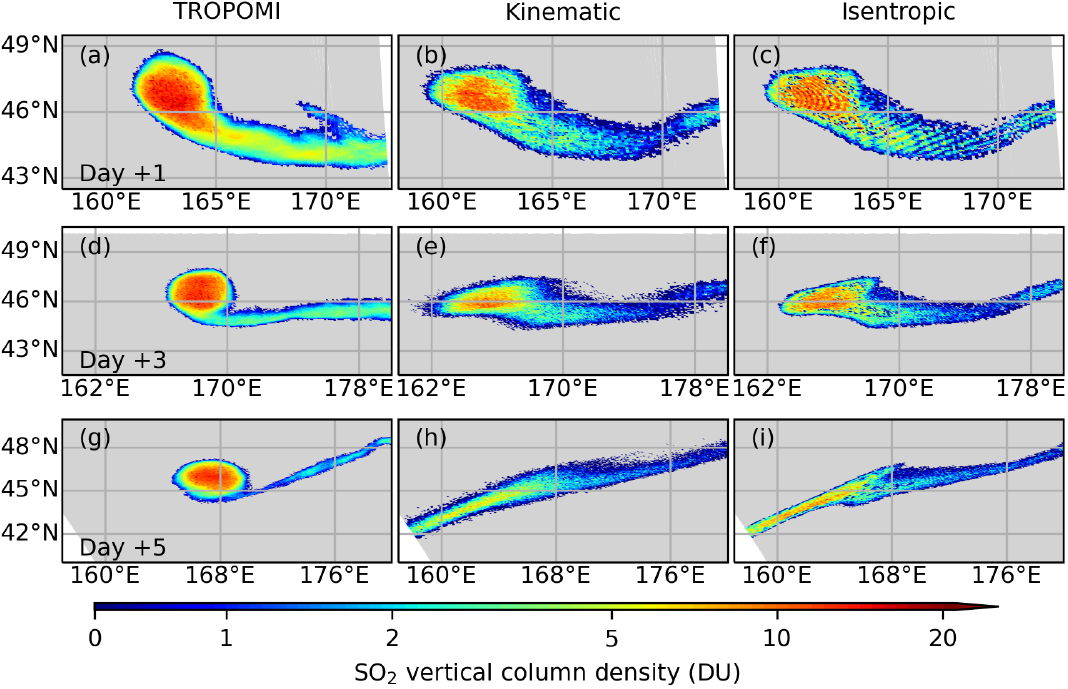
Figure 16. Forward simulation of the dispersion of the AC SO 2 cloud. Top row (a–c) : spatial distribution of SO 2 vertical column density from TROPOMI at 18 July 2019, 02:33UTC (a) , and the corresponding distribution in forward simulations, in which vertical motion was driven by vertical velocity (b) or by constant potential temperature (c) , respectively. Middle and bottom rows are the same as the top row but for 20 July 2019, 01:55UTC, and 22 July 2019, 01:18UTC,